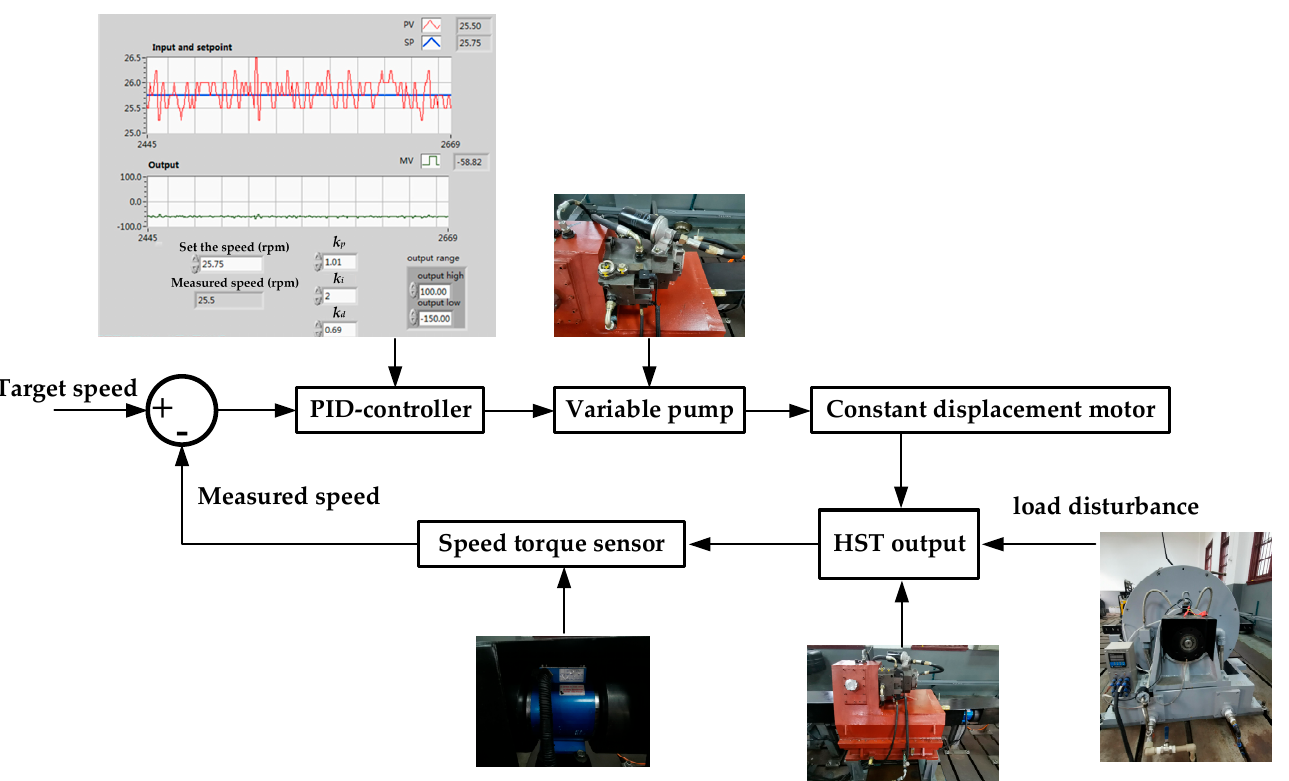
The PID controller’s input is the difference between the output speed and target